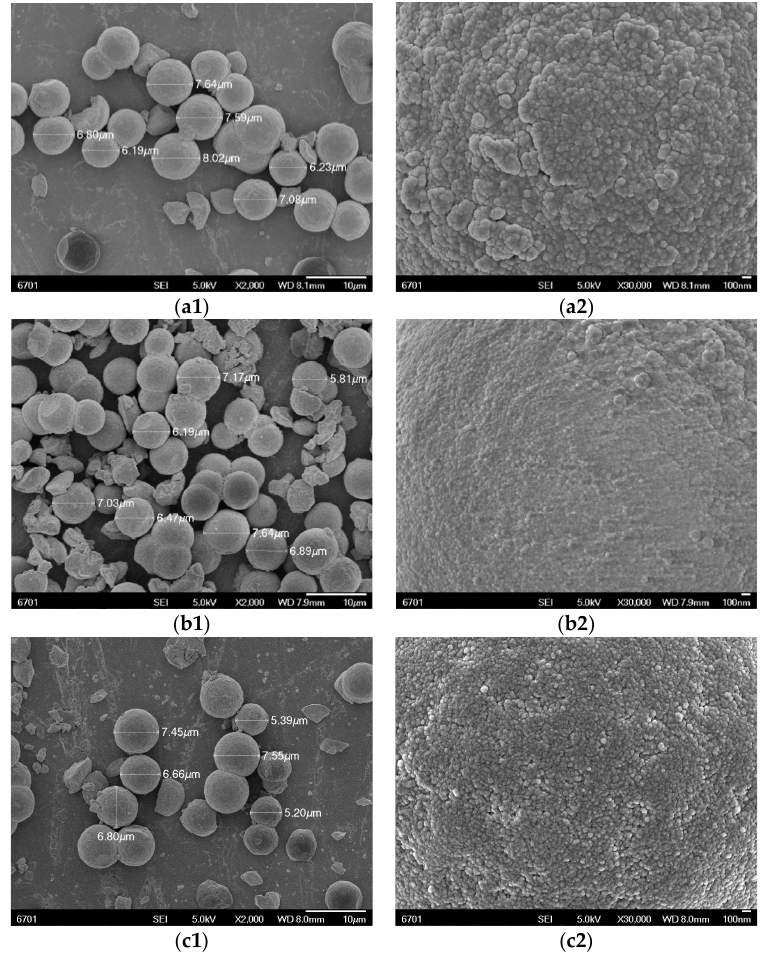
Figure 2. SEM images. OSMIP@silica gel ( a2 ) with the roughest surface. NIP@silica gel ( b2 ) with smoother surface. KH570@silica gel ( c2 ) with rougher surface than NIP@silica gel.